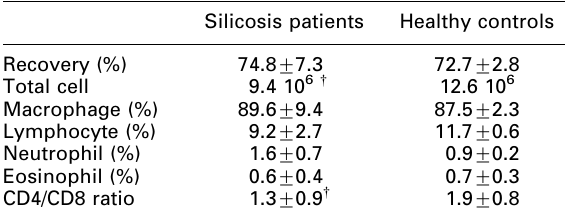
Table 1. Characteristics of BAL analysis in silicosis patients and in healthy controls Silicosis